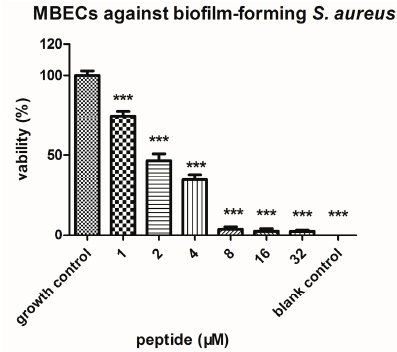
Figure 5. The MBEC (minimal biofilm eradication concentration) of PSN-PC against S. aureus biofilm. The results were analysed by one-way ANOVA, followed by the Newman-Keuls test, and showed differences between growth control and all concentrations of PSN-PC (***) p < 0.001.